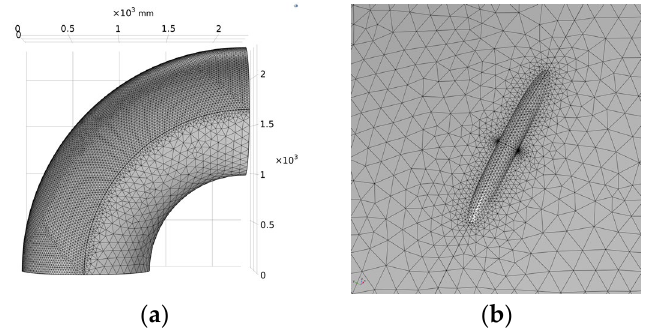
Figure 11. Mesh Schematic. ( a ) Overall meshing; ( b ) Meshing at defects.